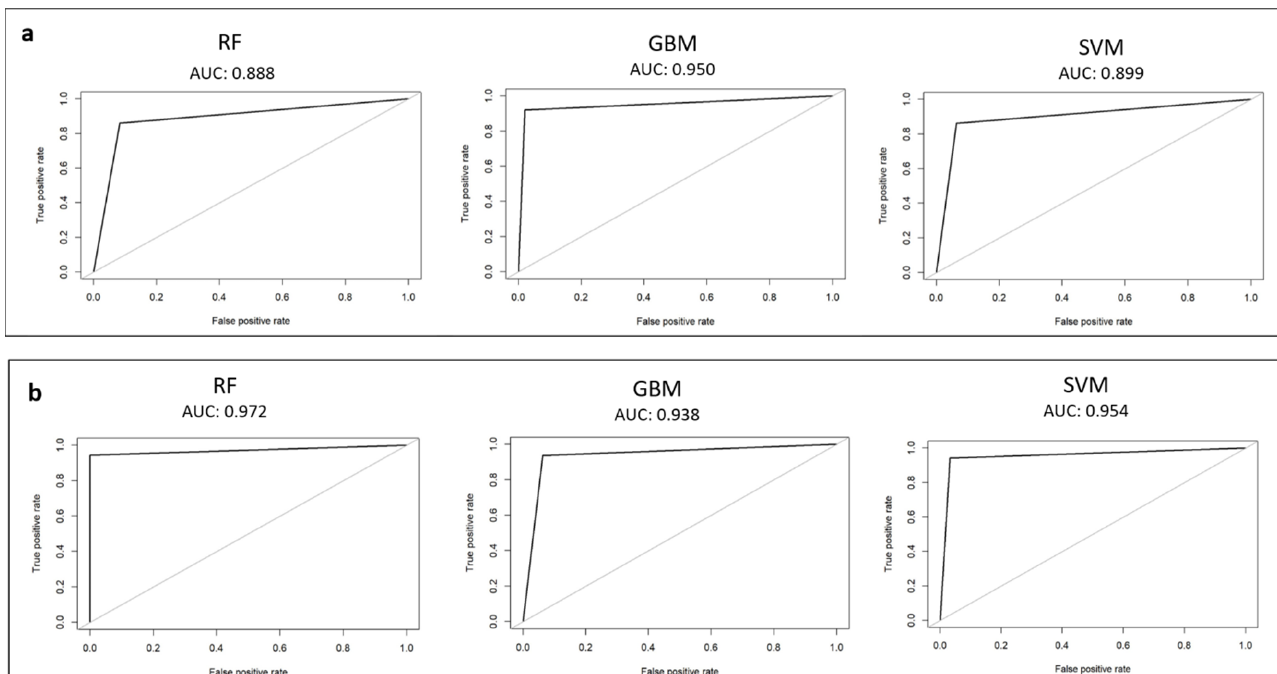
Figure 2. Receiver-operating characteristic (ROC) curve calculated on the test set for each model: ( a ) waste-tissue classification results; ( b ) ragged–not ragged classification results.